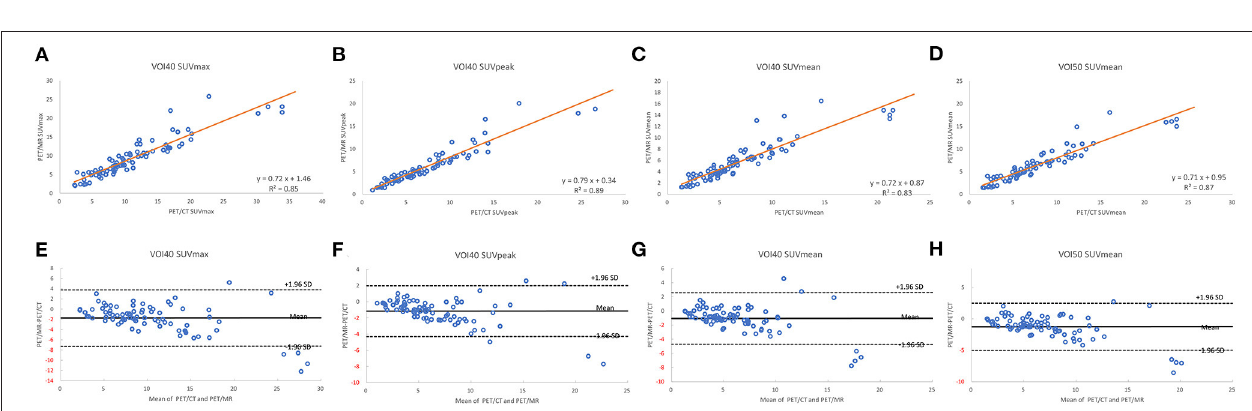
incorrect estimation of bone tissue AC correction factors affect mostly PET signal quantification or other regions proximity to bone and this effect becomes negligible for regions at